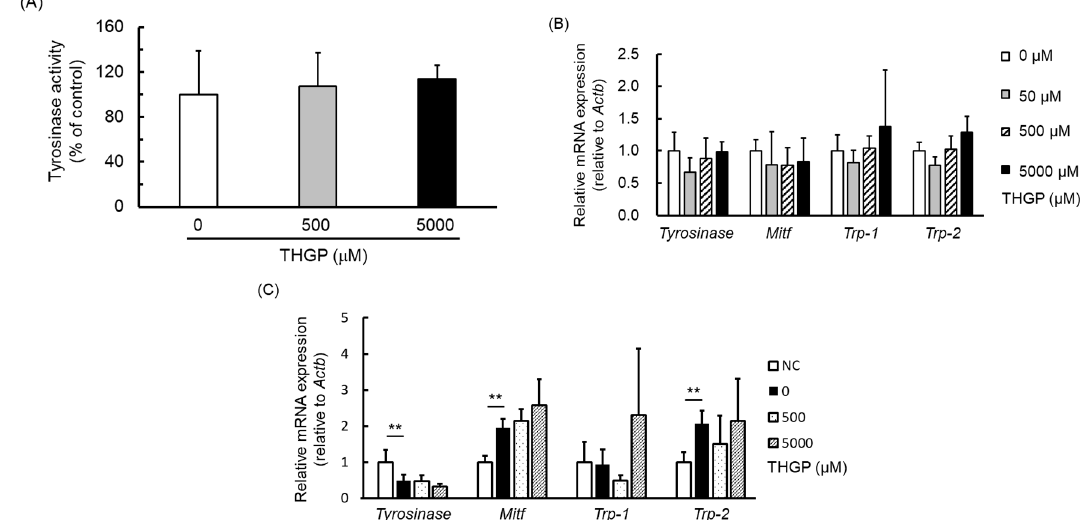
Figure 5. Effect of THGP on tyrosinase activity and the production of melanin production-related genes in B16 4A5 melanoma cells. ( A ) Tyrosinase activity was measured after treatment with THGP for 24 h. ( B ) The expression of genes after treatment with THGP for 24 h was assessed by real-time RT-PCR. ( C ) The expression of genes after treatment with THGP for 24 h with 100 µ M L-DOPA was assessed by real-time RT-PCR. NC is nontreated L-DOPA and THGP. The values shown are relative to the expression of β -actin (Actb), a housekeeping gene. The results were statistically analyzed by Dunnett’s method, and 0 µ M THGP with 100 µ M L-DOPA served as the control. The data are presented as the means ± SDs from six independent experiments. ** p < 0.01 vs. the control.